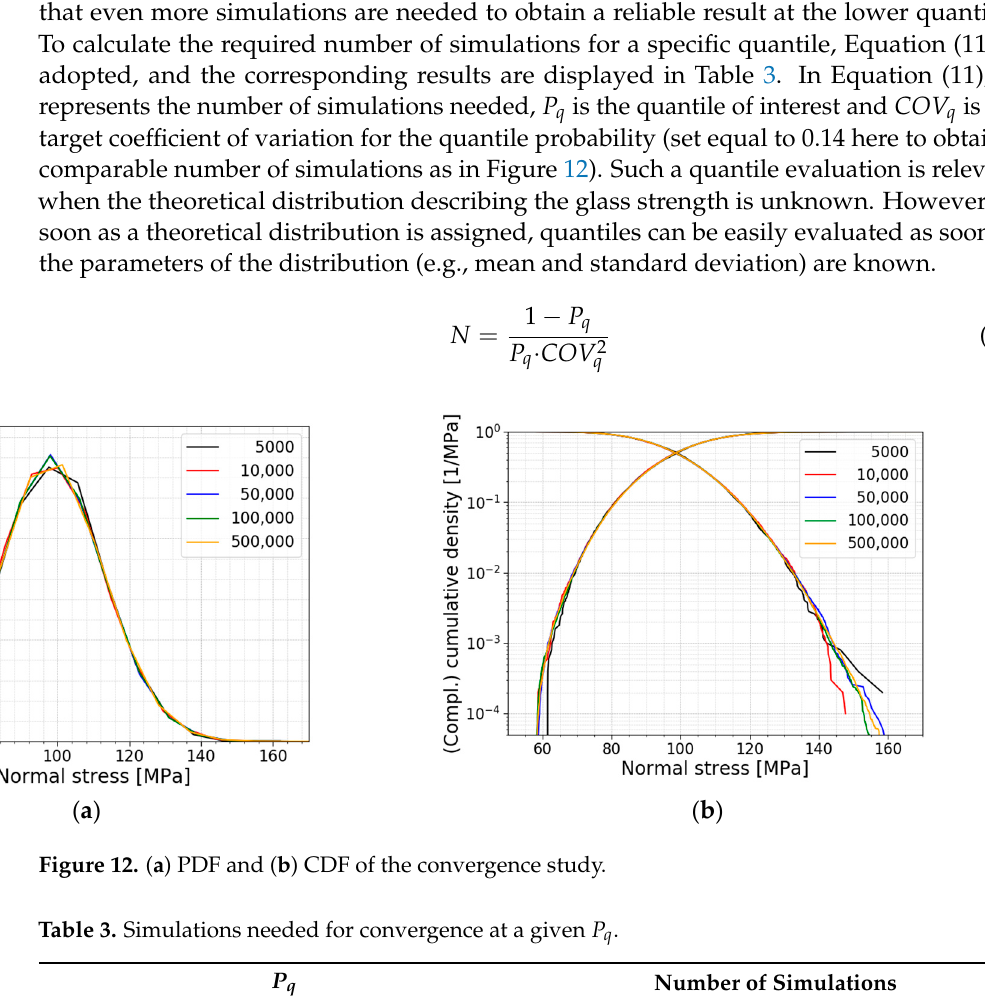
Figure 11. Convergence of ( a ) the mean value and ( b ) the standard deviation.